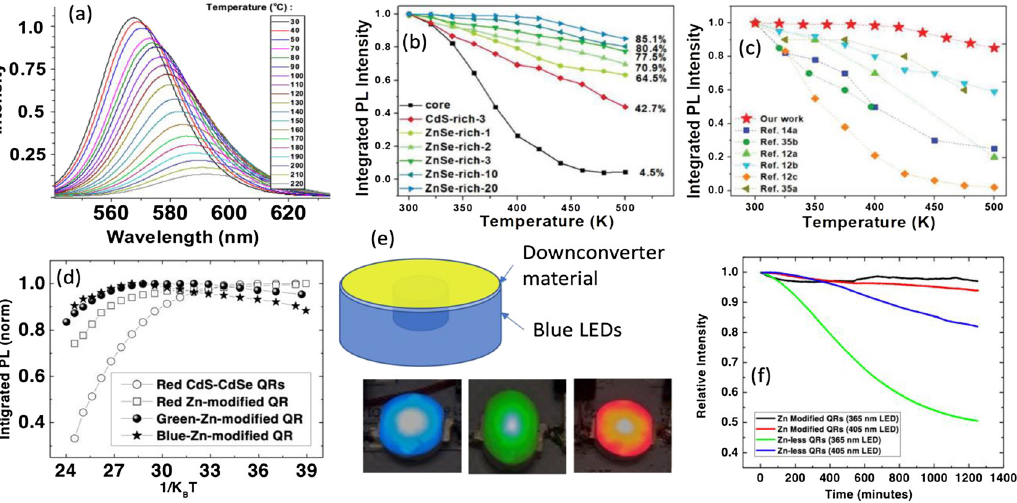
Figure 18: Temperature dependence of the PL properties of the Zn-doped nanoparticles. (a) Temperature dependence of the conventional Cd based QR/QDs, (b) and (c) shows the temperature dependence of the QDs doped with cd and Zn enrich material (taken from AOM). (d) Shows the temperature dependence of the Cd based QRs and Zn enrich QRS in all three colors (Taken from Small). (e) Shows the schematic of the QRLEDs and photos of the red, green, and blue QRLEDs. (f) Shows the time dependent PL intensity of the QRLED for the QRs with and without Zn